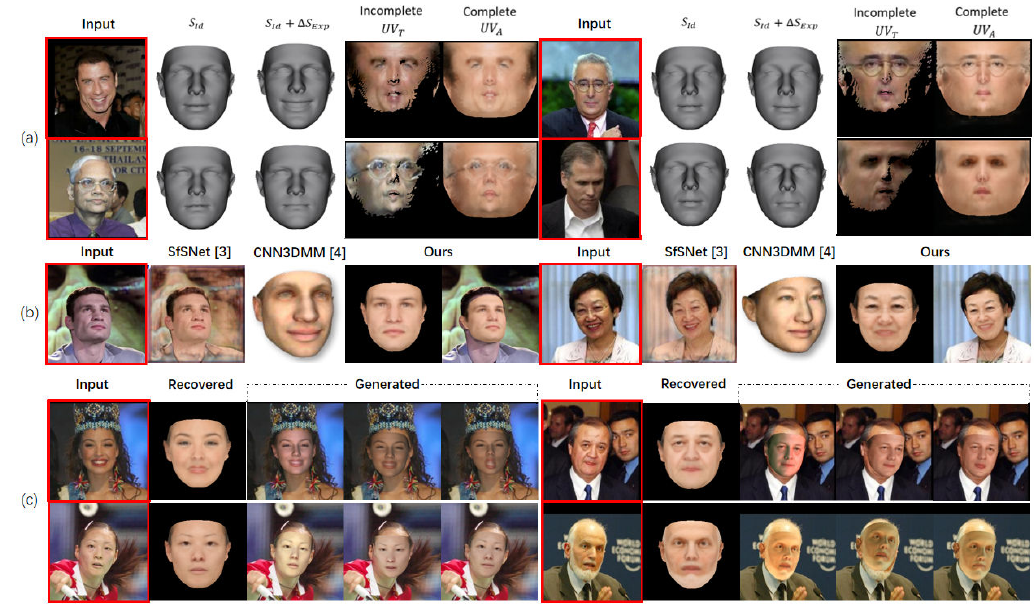
Figure 4. ( a ) Recovered 3D face shapes and albedo UV maps for two input face images by our 3D face modeling module. ( b ) Comparison between the face images reconstructed by our method and two existing methods. ( c ) Example enriched face images of varying illumination (Columns 3 and 8), pose (Columns 4 and 9), and expression (Columns 5 and 10) of four different subjects by our method.